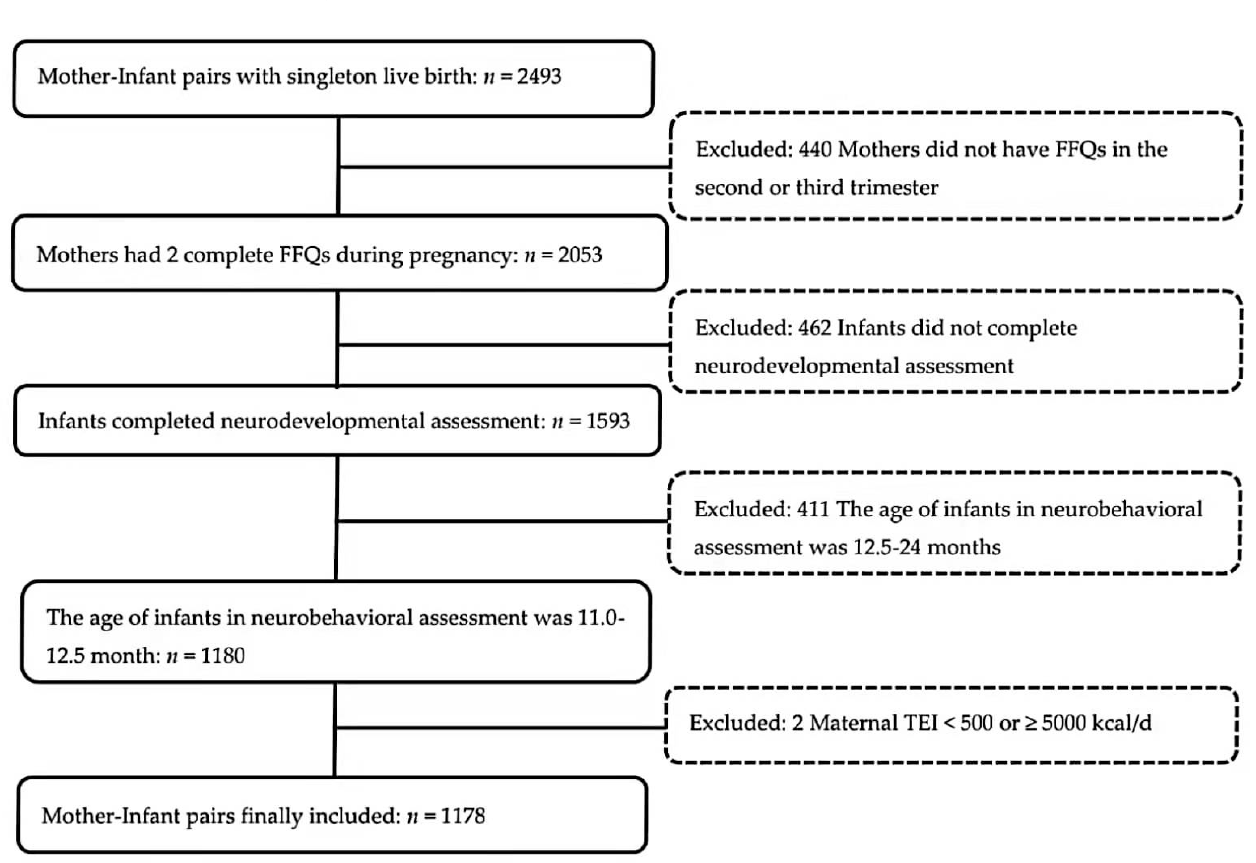
Figure 1. Participants flow chart. (Abbreviations: FFQ = food frequency questionnaire; TEI = total energy intake).